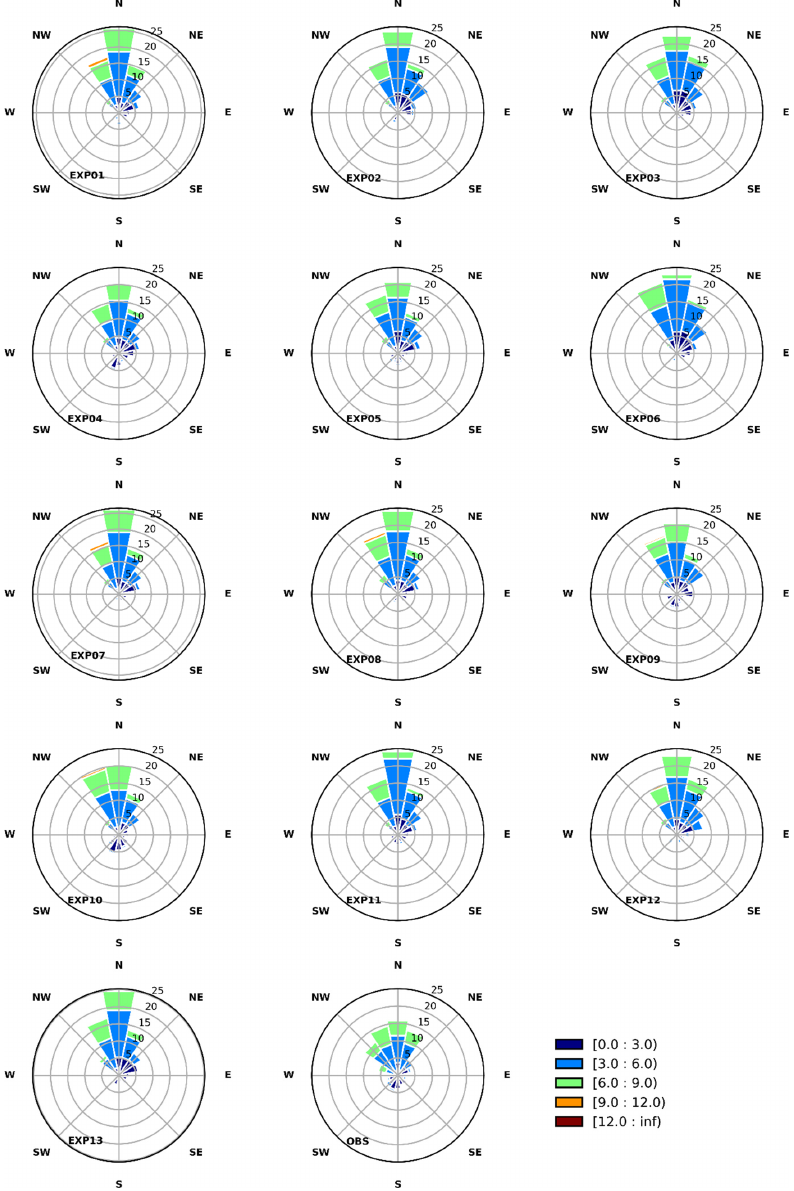
Figure 9. 10-m Wind roses at Barakah calculated for model simulations and observations for June 2019.